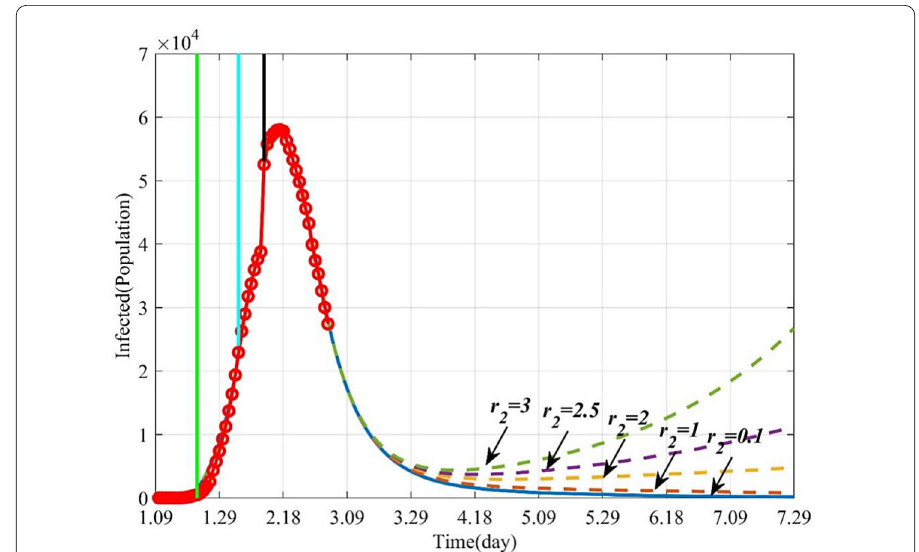
Figure 12 Dynamic trends of the infected with different r 2 . The solid line represents the trends of the infected with the current r 2 . The orange dotted line represents the trends of the infected when r 2 = 1. The yellow dotted line represents the trends of the infected when r 2 = 2. The purple dotted line represents the trends of the infected when r 2 = 2.5. The green dotted line represents the trends of the infected when r 2 = 3